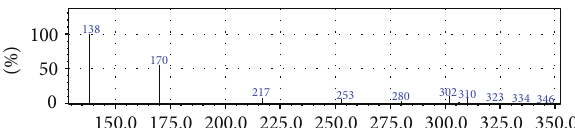
Figure 8: Mass spectra for standard 9,10-Anthraquinone before exposure to UV light.